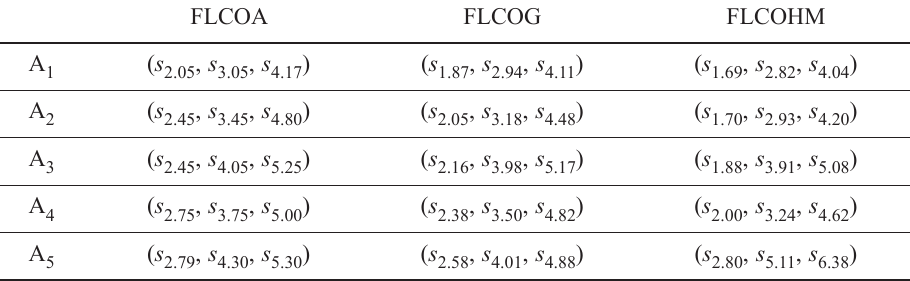
Table 2. The overall performance evaluation values of the emerging technology enterprises